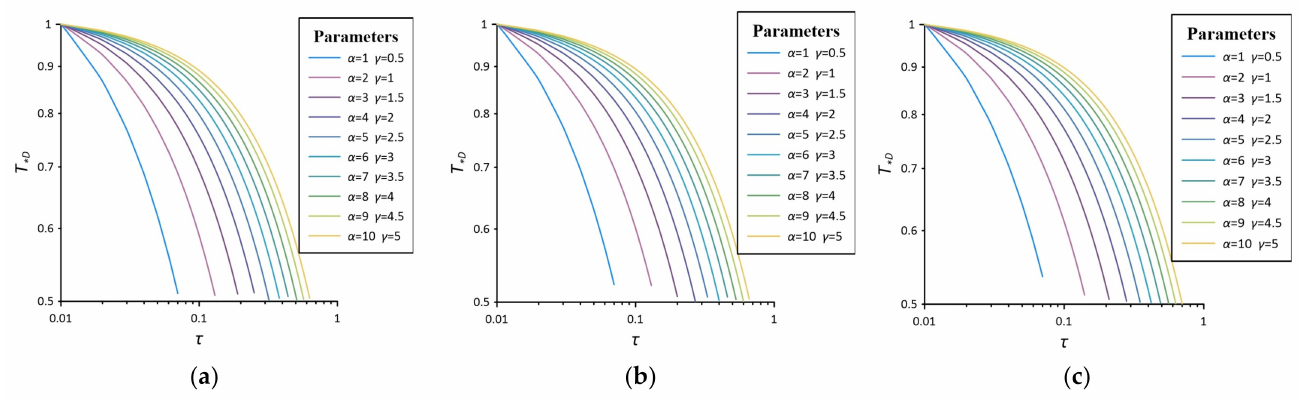
Figure 2. T ∗ D ∼ τ semi-logarithmic standard curves for different α and γ parameters in the case of u = 0.